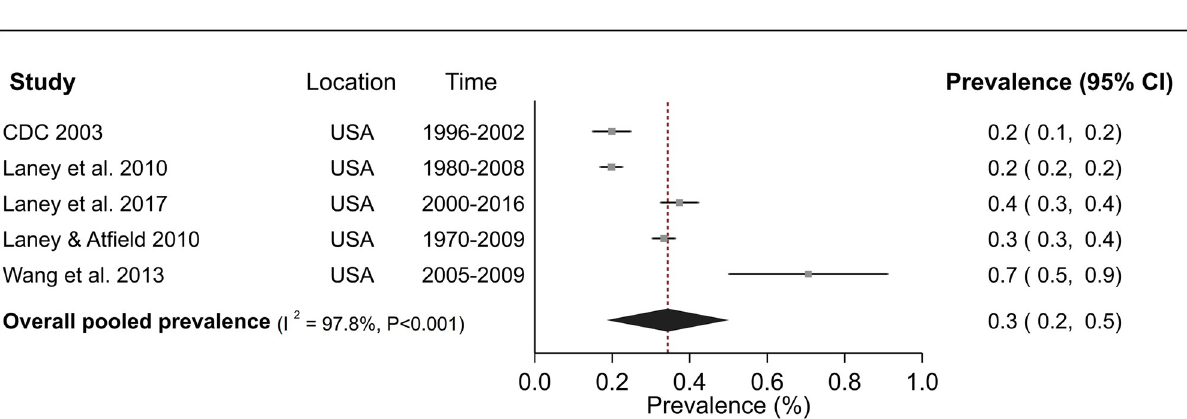
PLOS ONE | https://doi.org/10.1371/journal.pone.0255617 August 3,